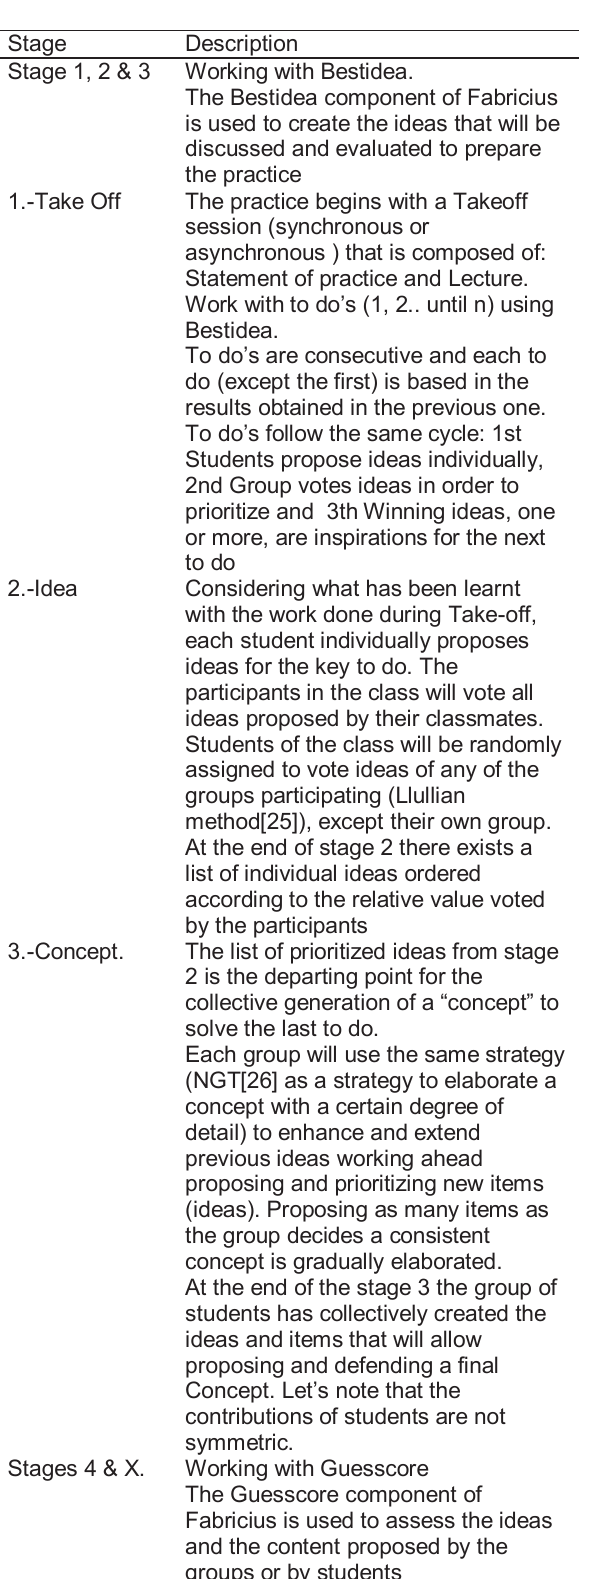
Table 3. Stages of model